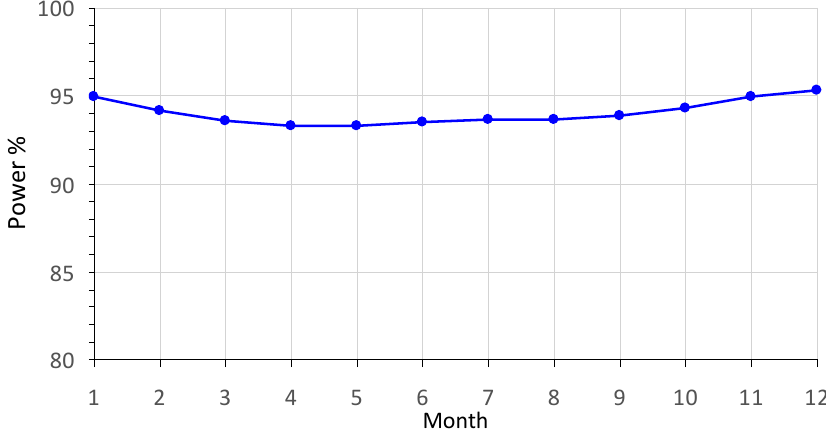
Figure 10. Estimation of the power from the PV module with integrated storage batteries in % compared to the original PV module without batteries, corresponding to Table 4.